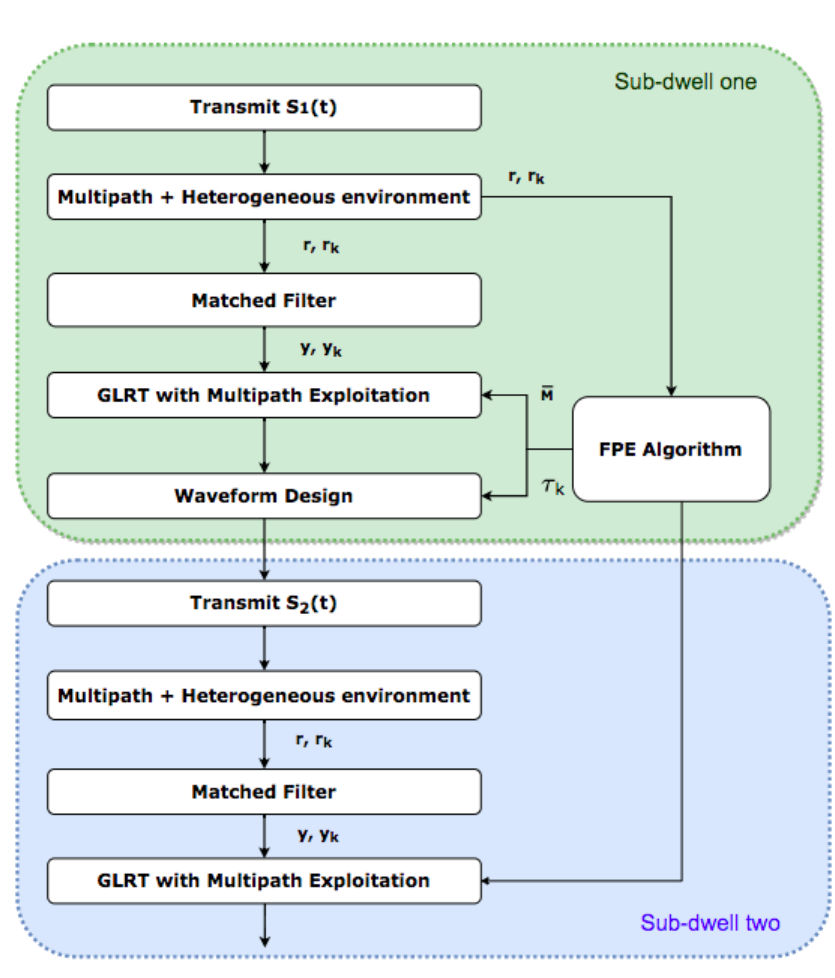
Figure 2. Block diagram of the proposed